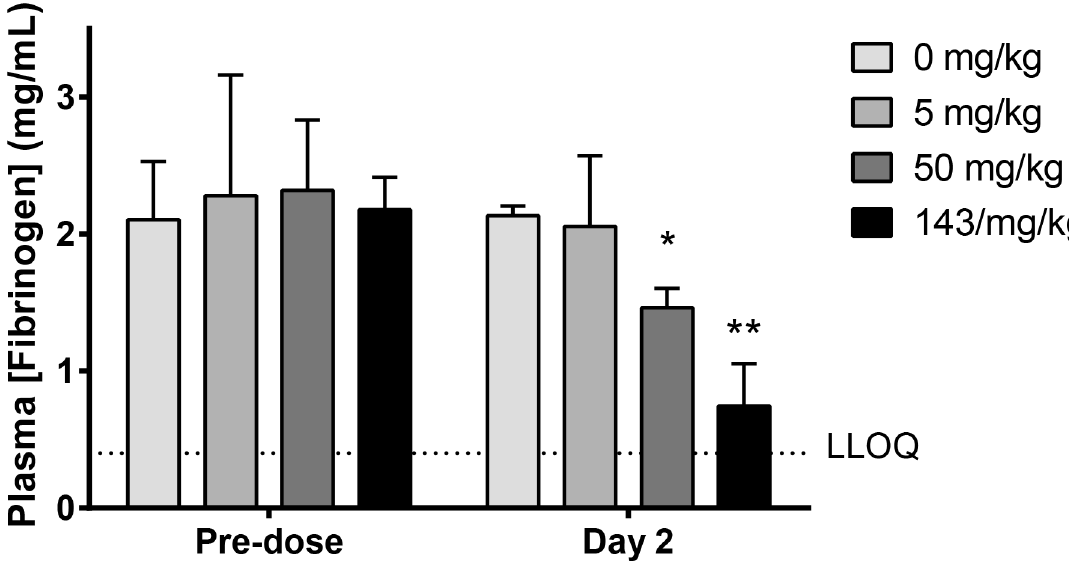
Fig 6. Effect of administration of HSA-NEPv on plasma fibrinogen concentrations in cynomolgus monkey. Fibrinogen concentrations were determined for plasma samples collected four days before dosing (Pre-dose) and 24 h after administration of with HSA-NEPv at 0, 5, 50 or 143 mg/kg (Day 2) (n = 3). LLOQ = lower limit of quantification (0.4 mg/mL). * P < 0.05; ** P < 0.01.